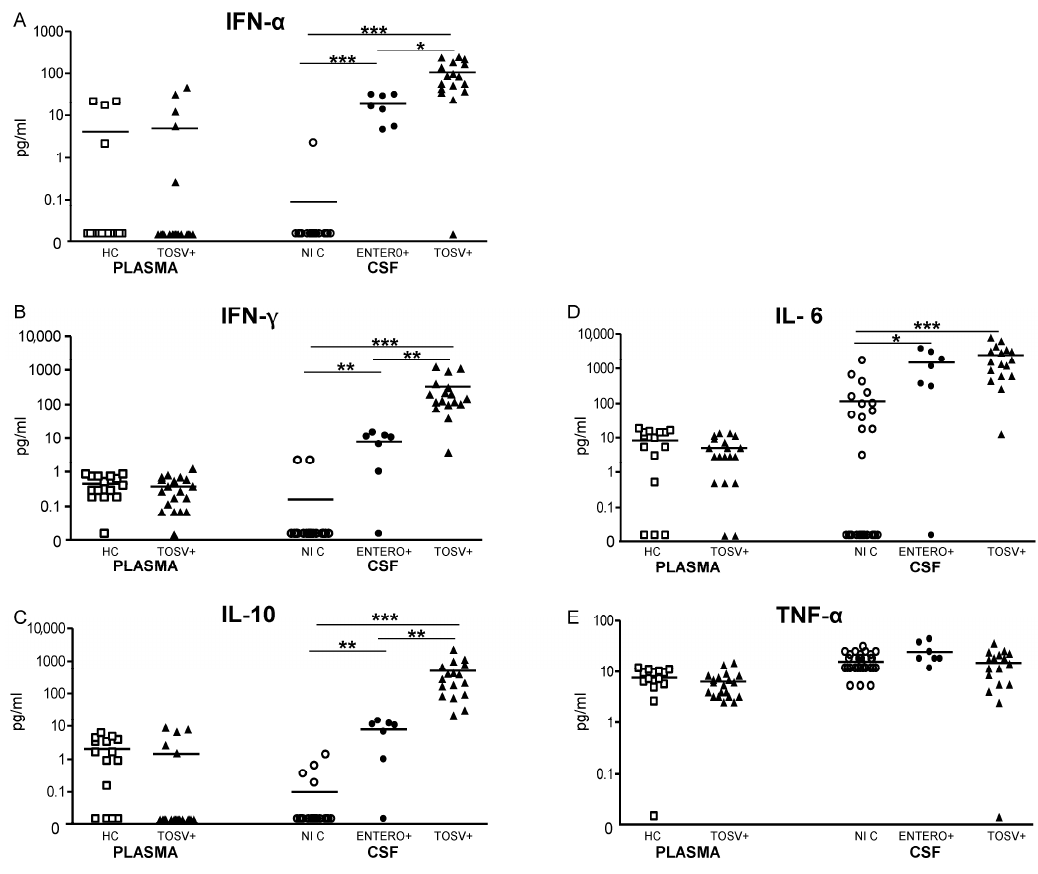
Figure 4. Levels of pro-inflammatory and anti-inflammatory cytokines in plasma and CSF from TOSV-infected patients and controls. The levels of IFN- α , IFN- γ , IL-6, IL-10, and TNF- α ( A – E ) were measured in the plasma samples from TOSV-infected patients (TOSV+) and from healthy controls (HC) as described in Materials and Methods. Cytokine levels were also measured in the CSF samples from TOSV-infected patients (TOSV+) and from patients with enterovirus meningitis (ENTERO+) and with noninfectious diseases of the CNS (noninfectious controls, NIC). White squares designate healthy controls ( n = 15), white circles indicate noninfectious controls ( n = 30), black circles designate enterovirus meningitis ( n = 7) and black triangles indicate TOSV-infected patients ( n = 17, 11 patients with meningitis and six patients with meningoencephalitis). Data were analyzed using the non-parametric Mann–Whitney U test. * indicates p ≤ 0.05, ** indicates p ≤ 0.01 and *** indicates p ≤ 0.001.